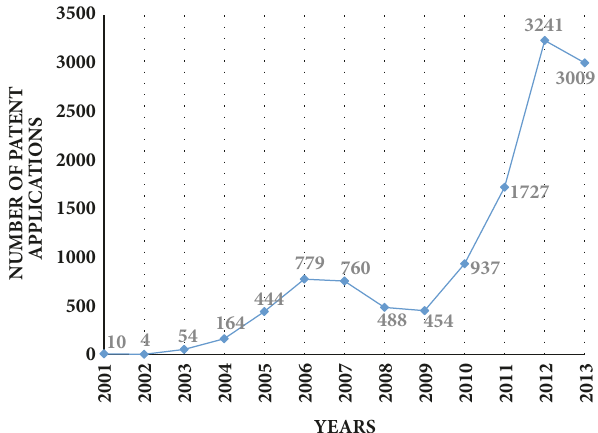
Figure 1: The number of Tencent’s patent applications in AI technology from 2001 to 2013.